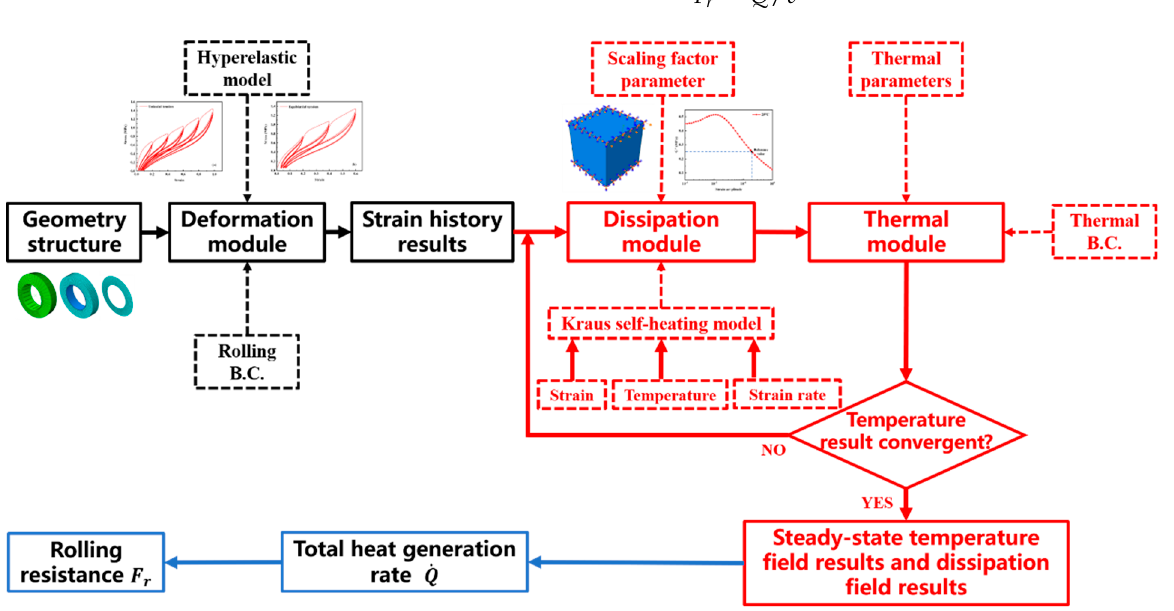
Figure 3. The flowchart of thermo-mechanical coupling analysis of the solid tire using Endurica and Abaqus co-simulation method. Abaqus co-simulation